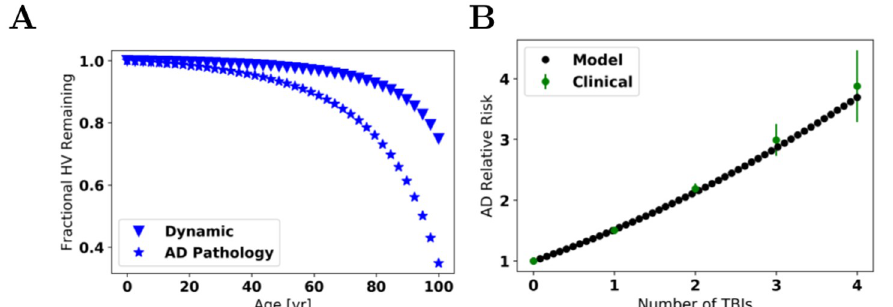
Fig 4. A : Time dependence of HV for the dynamic model with or without additional AD pathology. An HV of 1 is maximal. At age 75, the annual changes in hippocampal volume are − 0.015% (static model, not shown), − 0.29% (dynamic model), and − 1.1% (AD pathology model—rates have been scaled to match this value). The HV ratio between those at age 71.6 (AD pathology) to age 63.4 (CN) is 0.859. We can also compare within models . The hippocampal volume ratios between age 71.6 to age 63.4 years are as follows: 0.999 (static), 0.984 (dynamic), and 0.944 (AD pathology). B : Traumatic Brain Injury . Our fit to clinical data [56] for the relative hazard rate ^ R vs number of TBIs, n . The error bars represent one standard error. Model fit: ^ R ð n Þ ¼ ð 1 þ an Þ 2 with a ¼ A = � S to be estimated. The fitted value is a = 0.231.